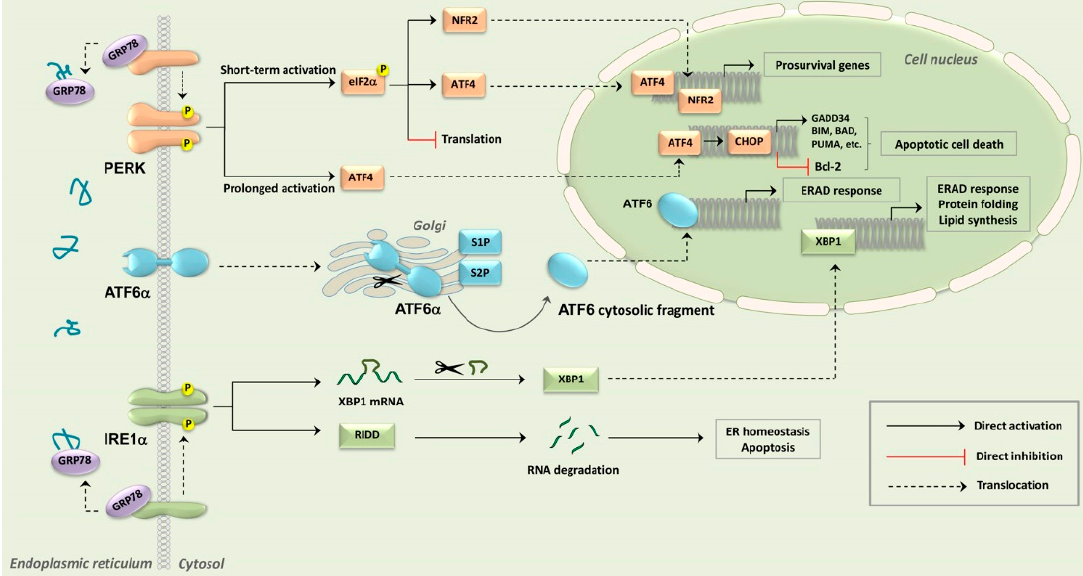
Figure 1. The three arms of the unfolded protein response (UPR). For the details see the text. Abbreviations used are: ATF4; Activating transcription factor 4; ATF6 α : Activating transcription